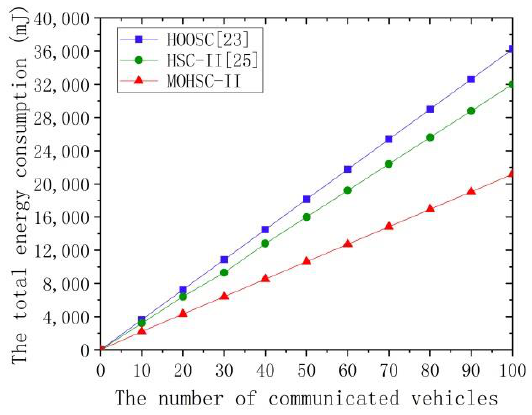
Figure 6. Comparisons of total energy consumption (IBC → PKI).